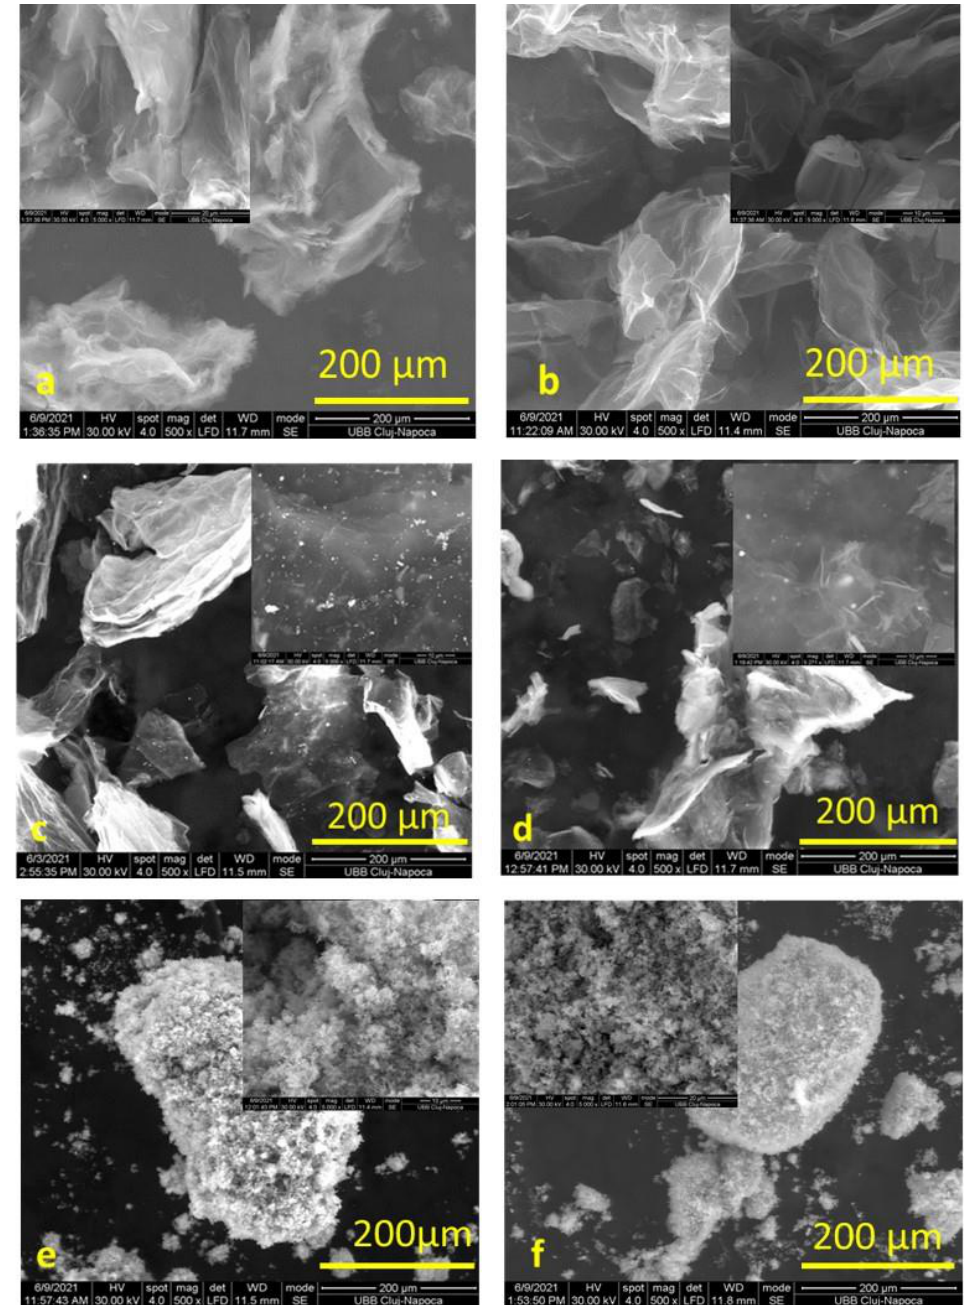
Figure 7. SEM images of the: ( a ) GO, ( b ) GO-APTES ( c ) GO-Ag, ( d ) GO-Ag-APTES, ( e ) GO-ZnO and ( f ) GO-ZnO-APTES powders, at ×500 and (×5000 superimposed) magnifications.